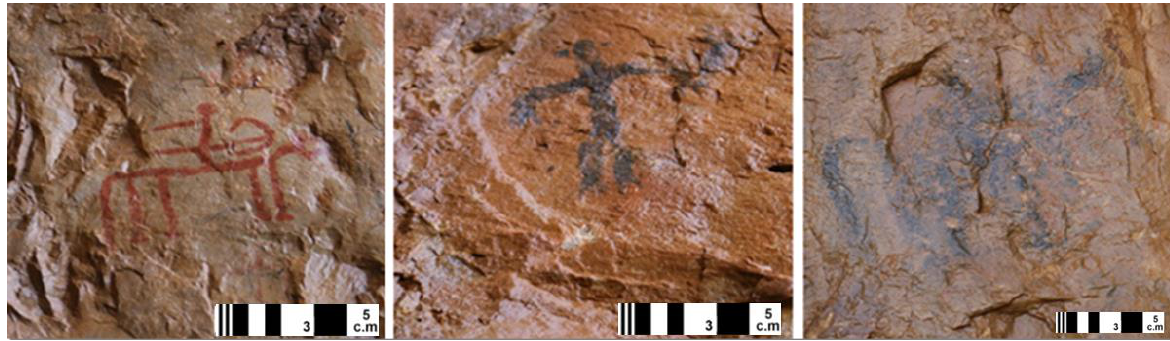
Figure 4. “Ibex” with long and curved or jag horns motifs in the Shamsali Rock shelter.